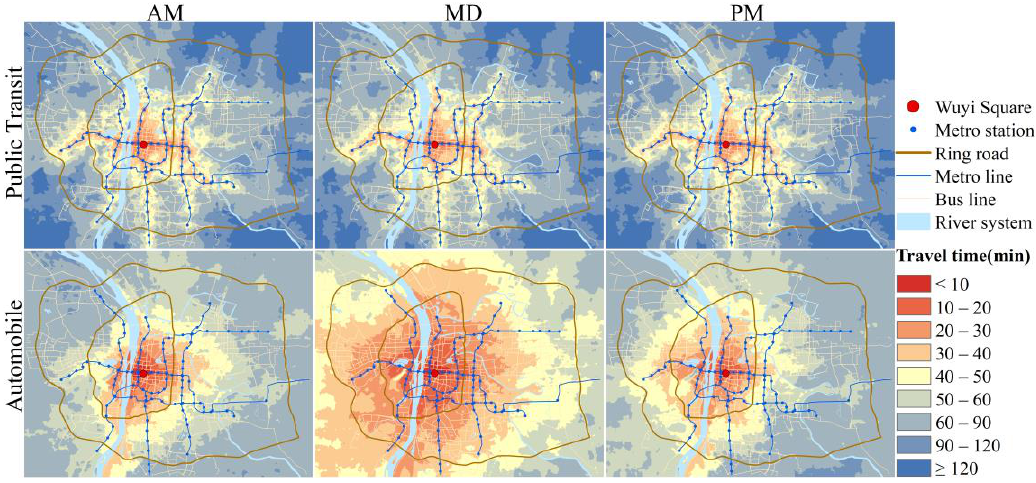
Figure 2. Isochrone maps of automobile and PT for the three time periods. Table 1. Travel time by two modes and time-ratio for the three time